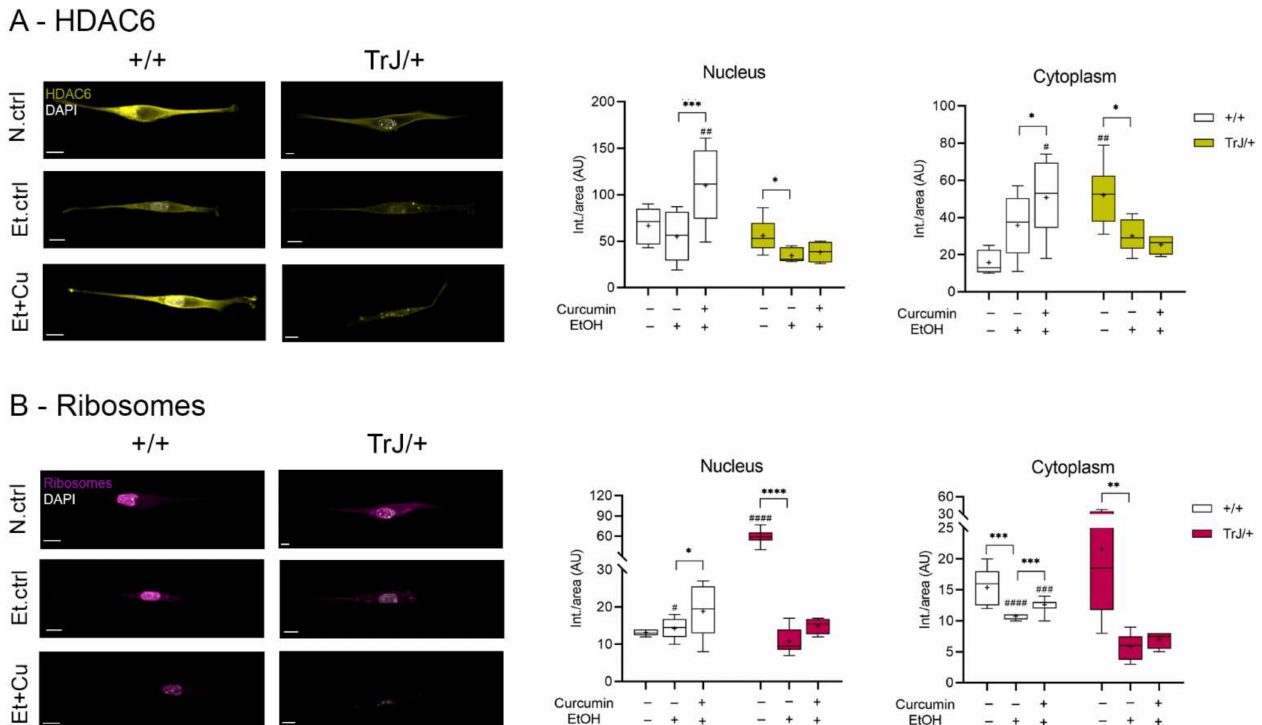
Figure 6. Modulation of HDAC6 and ribosome expression in +/+ and TrJ/+ SC enriched cultures. Images obtained by confocal microscopy of +/+ and TrJ/+ SC in N.ctrl, E.ctrl, and Et+Cu were quantified in the nucleus and cytoplasm. ( A ) HDAC6 expression. Et.ctrl vs. N.ctrl showed a decrease only in TrJ/+ SCs in both compartments. Et+Cu vs. Et.ctrl showed an increase in +/+ SCs in both compartments. Conversely, the same condition between +/+ and TrJ/+ SCs revealed nuclear differences only with Et+Cu. At the cytoplasmic level, differences were observed with the N.ctrl and Et+Cu; ( B ) Ribosome’s expression. Et.ctrl vs. N.ctrl, showed a nuclear decrease only in TrJ/+, while the cytoplasmic decrease occurred in both genotypes. Et+Cu vs. Et.ctrl showed an increased expression in +/+ SCs in both compartments. +/+ vs. TrJ/+ SCs revealed nuclear differences with the N.ctrl and the Et.ctrl, and cytoplasmic differences with Et.ctrl and Et+Cu treatment. Within each genotype: * p < 0.033; ** p < 0.002; *** p < 0.0002; **** p < 0.0001. Same treatment, +/+ vs. TrJ/+; # p < 0.033; ## p < 0.002; ### p < 0.0002; #### p < 0.0001. The mean is shown as “+”. Scale = 10 µ m